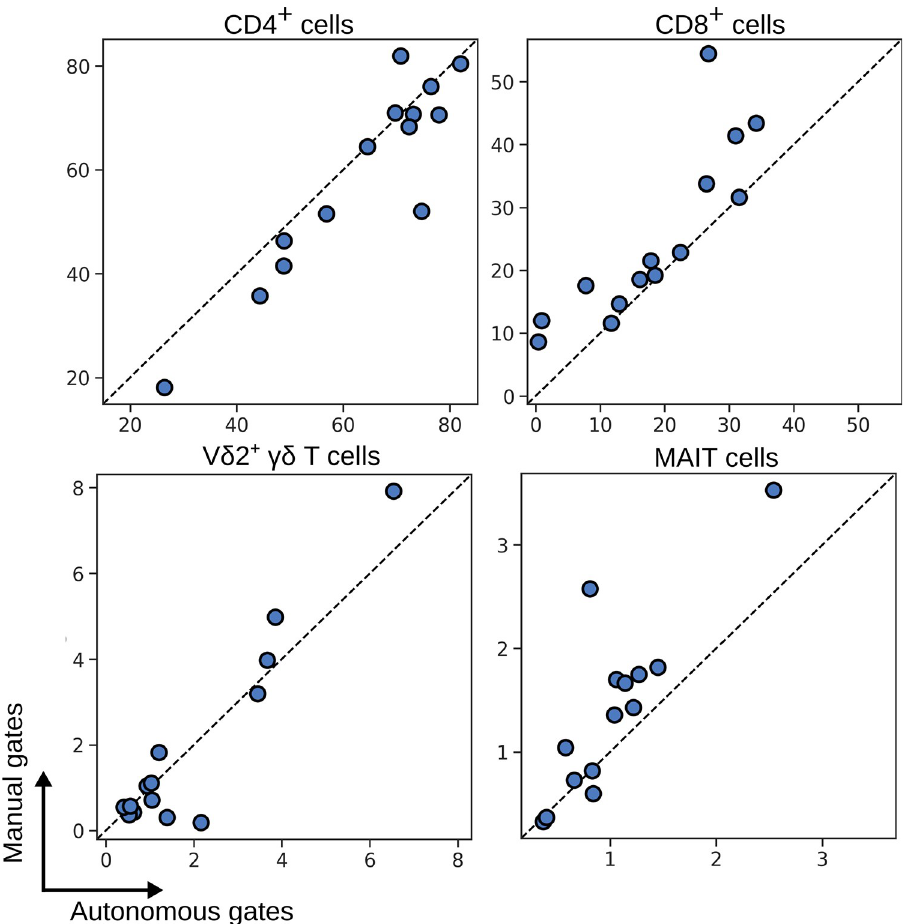
Fig 5. Percentage of blood T cell subsets as identified by XGBoost compared to the same subsets as identified by expert manual gates. Each symbol depicts results obtained with cells from an individual